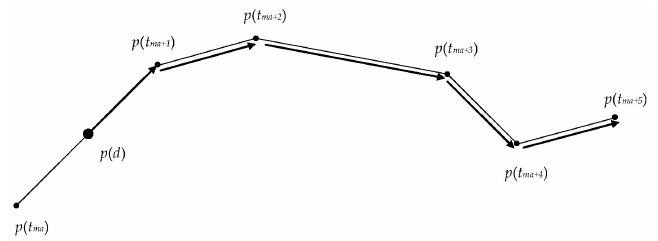
Figure 15. Schematic diagram of cumulative distance.